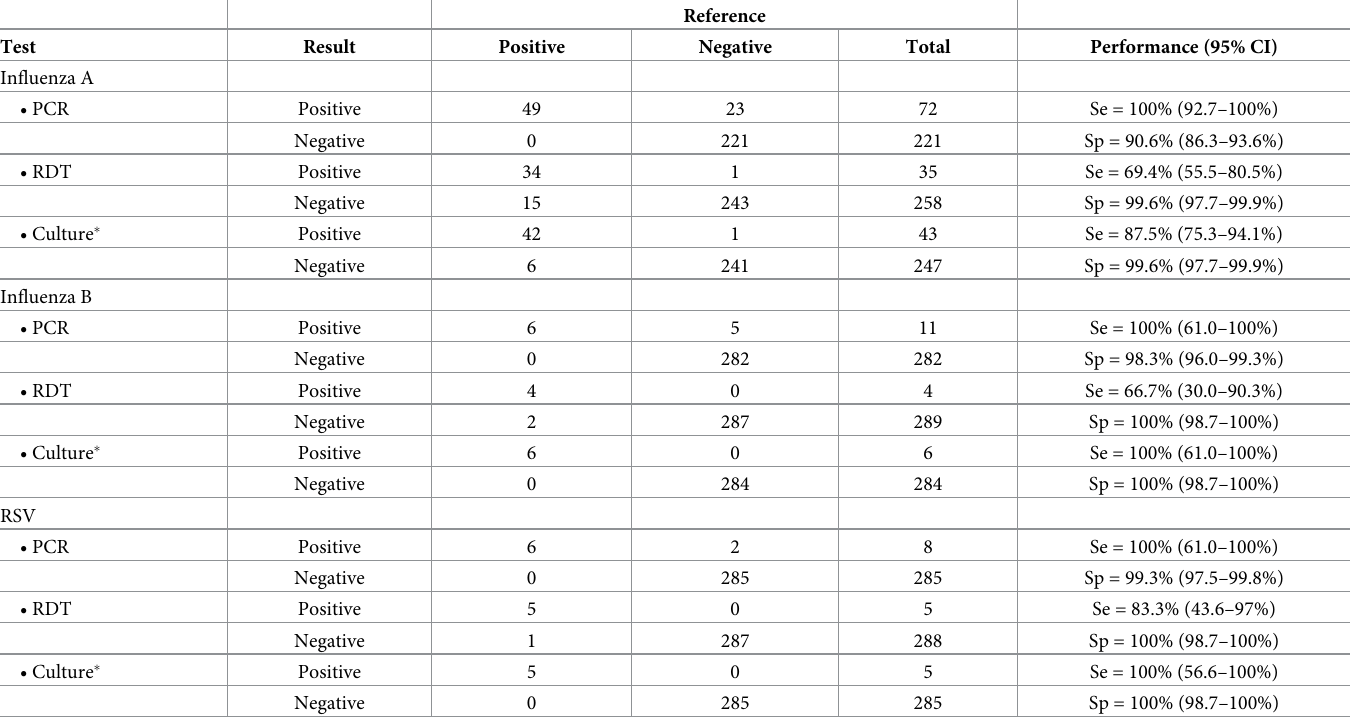
Table 2. Analytical performance (Se: Sensitivity, Sp: Specificity) and Wilson 95% confidence interval (CI) of the Cobas 1 Liat Influenza A/B & RSV assay (PCR), antigen tests (RDT) and viral culture for the diagnosis of influenza A, B and RSV using a composite reference standard (samples considered positive or negative if tested as such by at least 2 of the 3 techniques